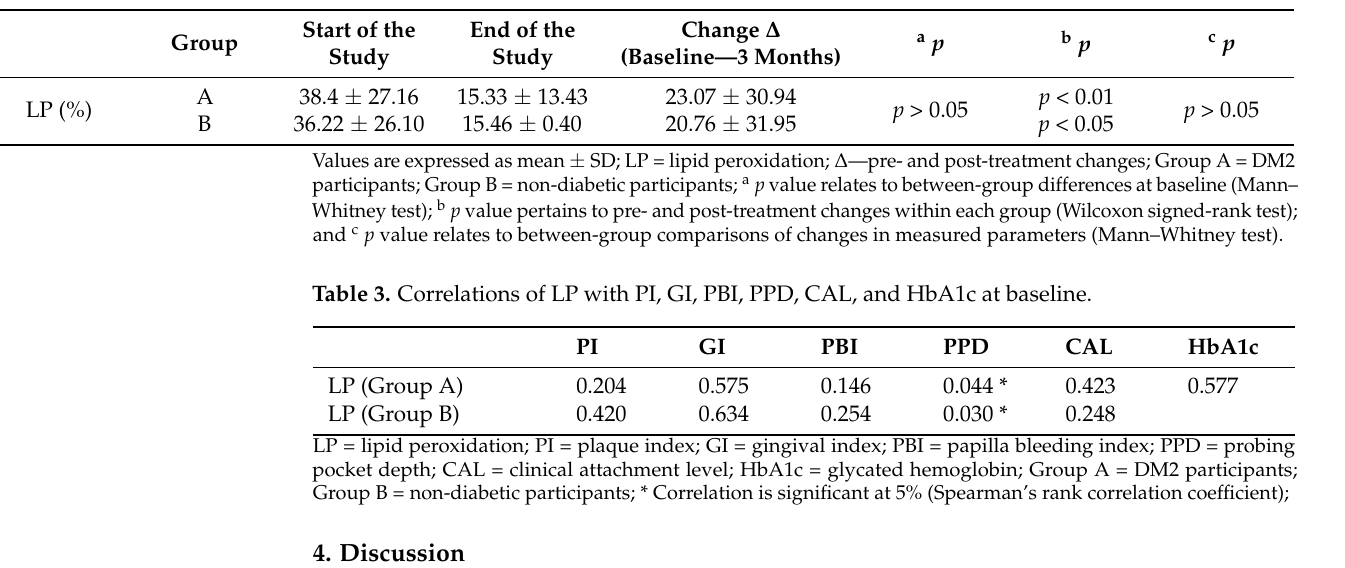
Table 2. Comparison of LP at the start and end of the study.